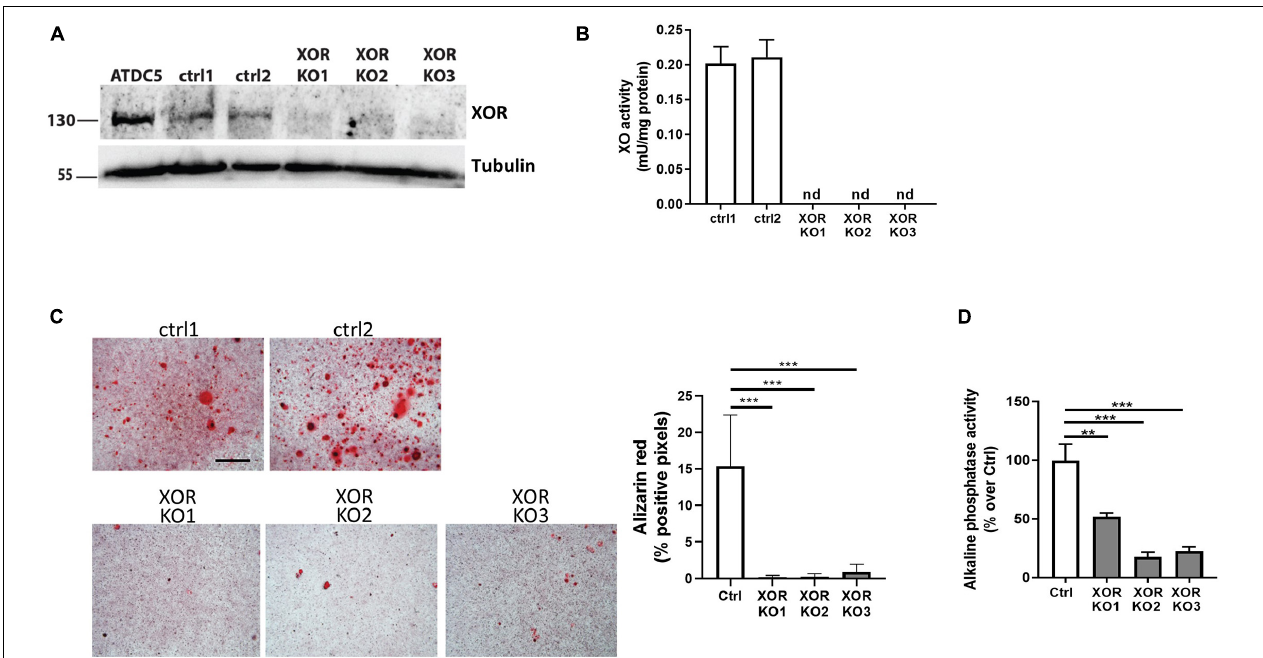
FIGURE 1 | CRISPR/Cas9-mediated depletion of XOR leads to decreased chondrocyte mineralization. (A) Immunoblot analysis of XOR expression in cell extracts from ATDC5 cells, ATDC5 cell clones transduced with lentiviral control constructs (ctrl1, ctrl2), or lentiviral constructs with gRNA for XOR knock-out (XOR KO1, XOR KO2, XOR KO3). Equal amount of protein loading in the different samples was assessed by tubulin immunoblot. (B) XO activity in cell extracts from ATDC5 control (ctrl1 and ctrl2) and XOR knock-out (XOR KO1, XOR KO2, XOR KO3) clones. XO activity was determined by Amplex Red. (C) Alizarin red staining and quantification of Ctrl and XOR KO chondrocyte cell lines cultured with CPP for 24 h. Pictures are representative of one experiment of three independent experiments. Scale bar 400 µ M. (D) Alkaline phospatase activity measurement in cell homogenates from Ctrl and XOR KO chondrocytes cultured with CPP for 6 hrs. ∗∗ p < 0.01, ∗∗∗ p <